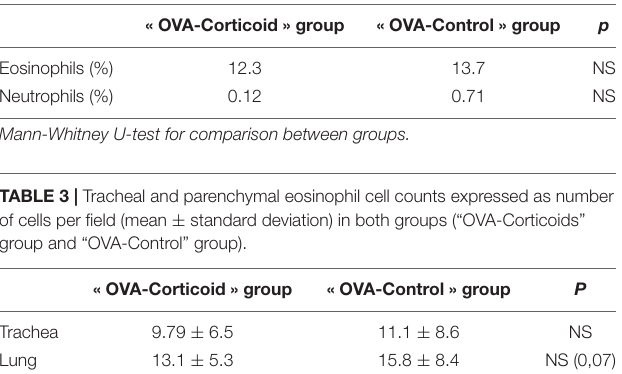
TABLE 2 | Mean cell counts of eosinophils and neutrophils in bronchoalveolar lavage (expressed as% of total cell count) in both groups (“OVA-Corticoids” group and “OVA-Control” group).